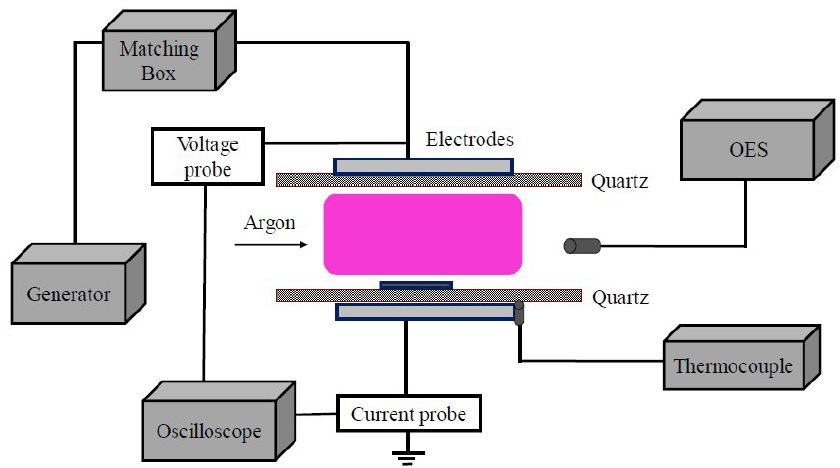
Figure 1. Schematic RF plasma treatment experimental set up.